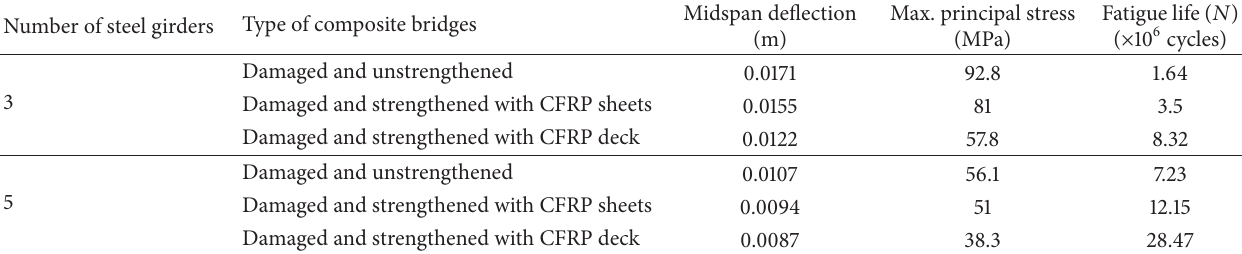
Table 6: Full results of FE analyses of damaged (with 3 mm crack) composite bridges.